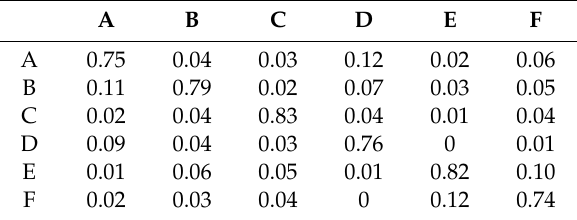
Table 1. Support Vector Machine classification accuracy after genetic selection algorithm optimization.